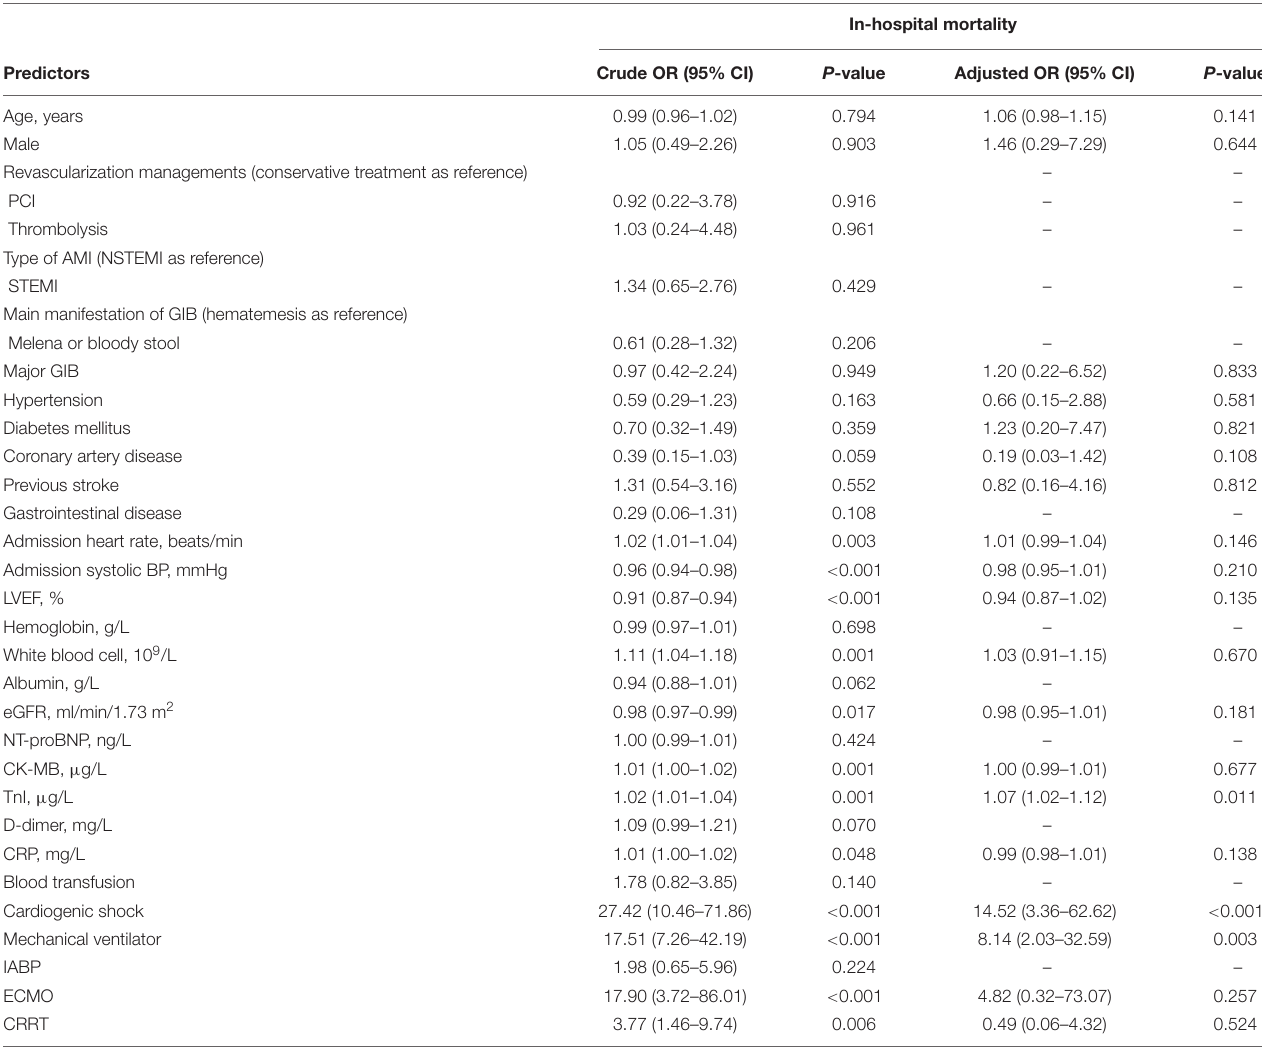
TABLE 2 | Independent risk factors of in-hospital